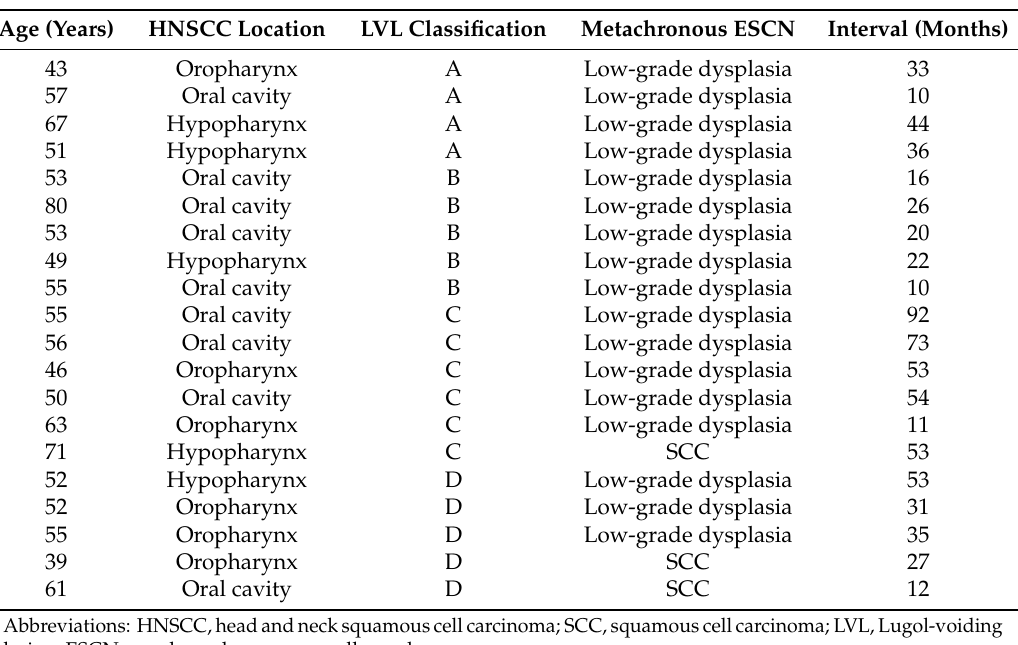
Table 3. Characteristics of 20 patients with metachronous ESCNs.